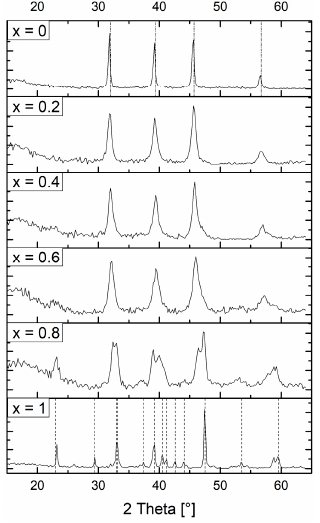
Figure 8. XRDs of annealed xerogels 9, 13 – 17 , pdf x=0 : 18-1033, star, pdf x=1 : 81-952.